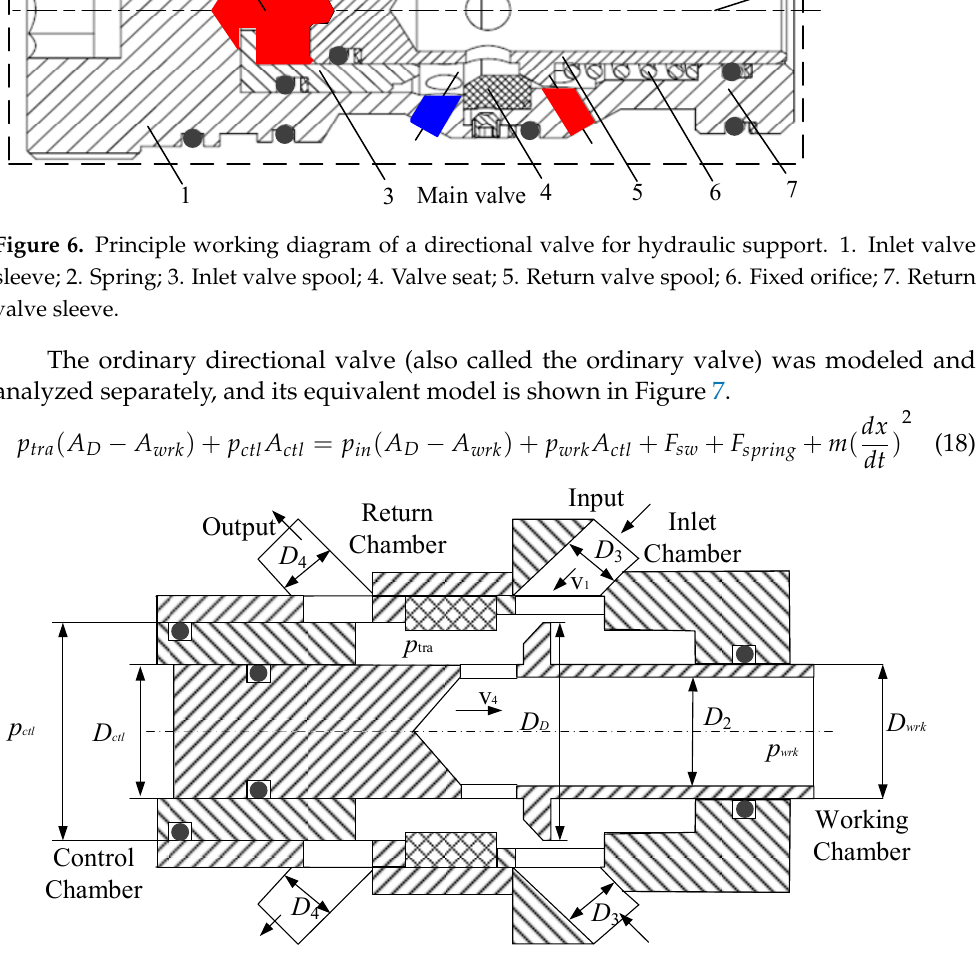
Figure 6. Principle working diagram of a directional valve for hydraulic support. 1. Inlet valve sleeve; 2. Spring; 3. Inlet valve spool; 4. Valve seat; 5. Return valve spool; 6. Fixed orifice; 7. Return valve sleeve.